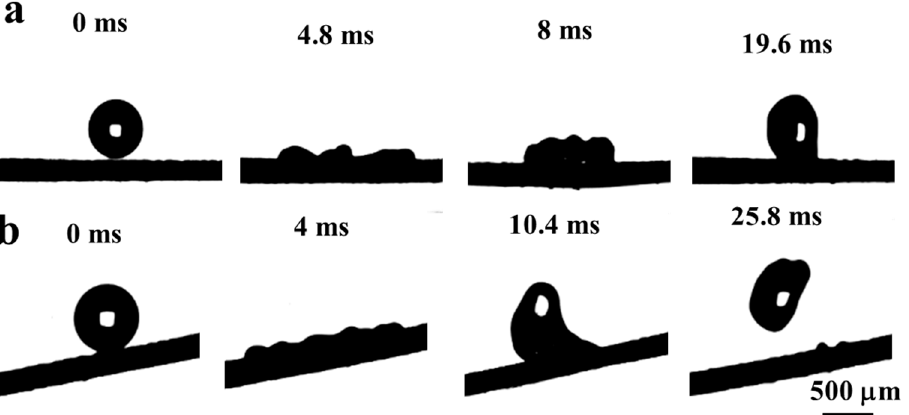
Figure 10. Droplet impacting on the ( a ) horizontal and ( b ) inclined time of droplet elastic cold hydrophobic membrane surface at 10° titled angle with 0.6 m/s impacting speed.